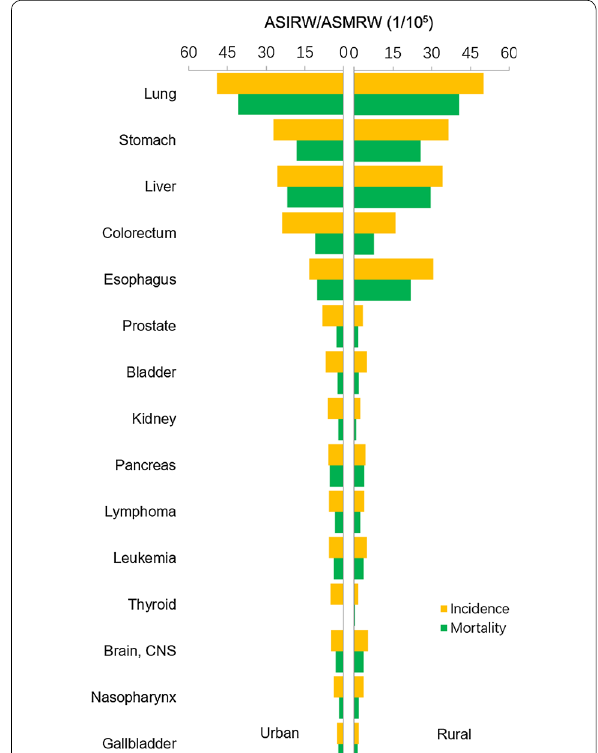
Fig. 2 ASIRW and ASMRW in urban areas and rural areas for males in China, 2013. ASMRW age-standardized mortality rate adjusted by the world Segi’s